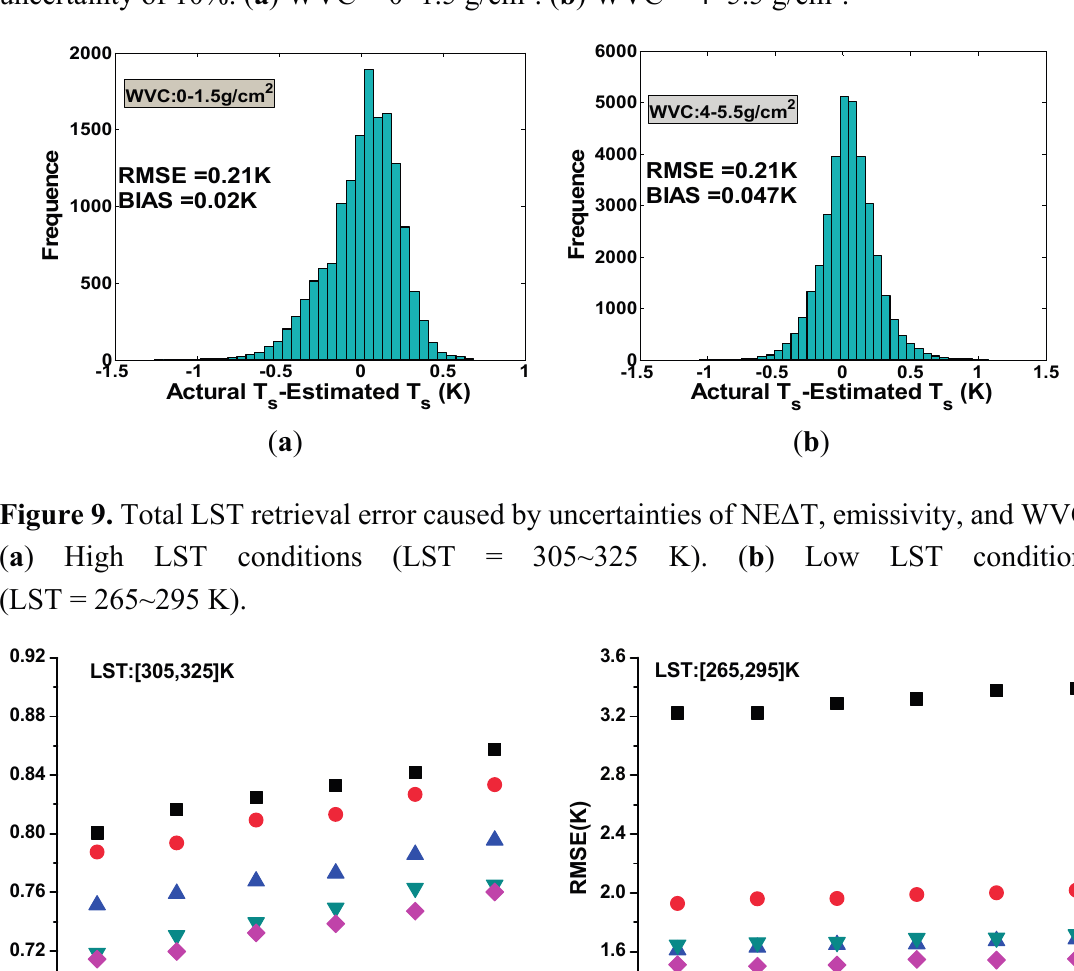
Figure 8. Histogram of the difference between the actual and estimated T s caused by a WVC uncertainty of 10%. ( a ) WVC = 0~1.5 g/cm 2 . ( b ) WVC = 4~5.5 g/cm 2 .